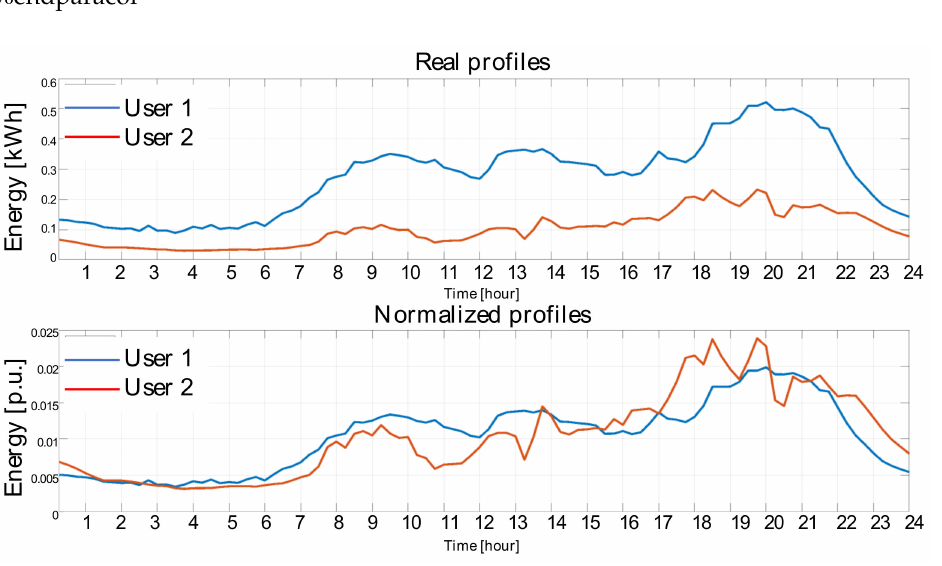
Figure 4. Real vs. normalized daily profiles of two residential